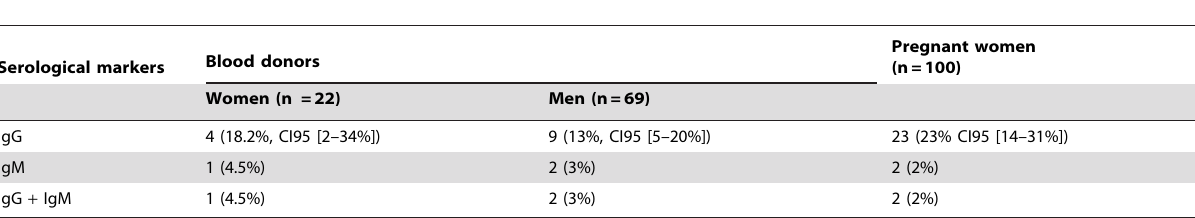
Table 1. Prevalence of anti-HAV IgG and IgM in pregnant women and blood donors.